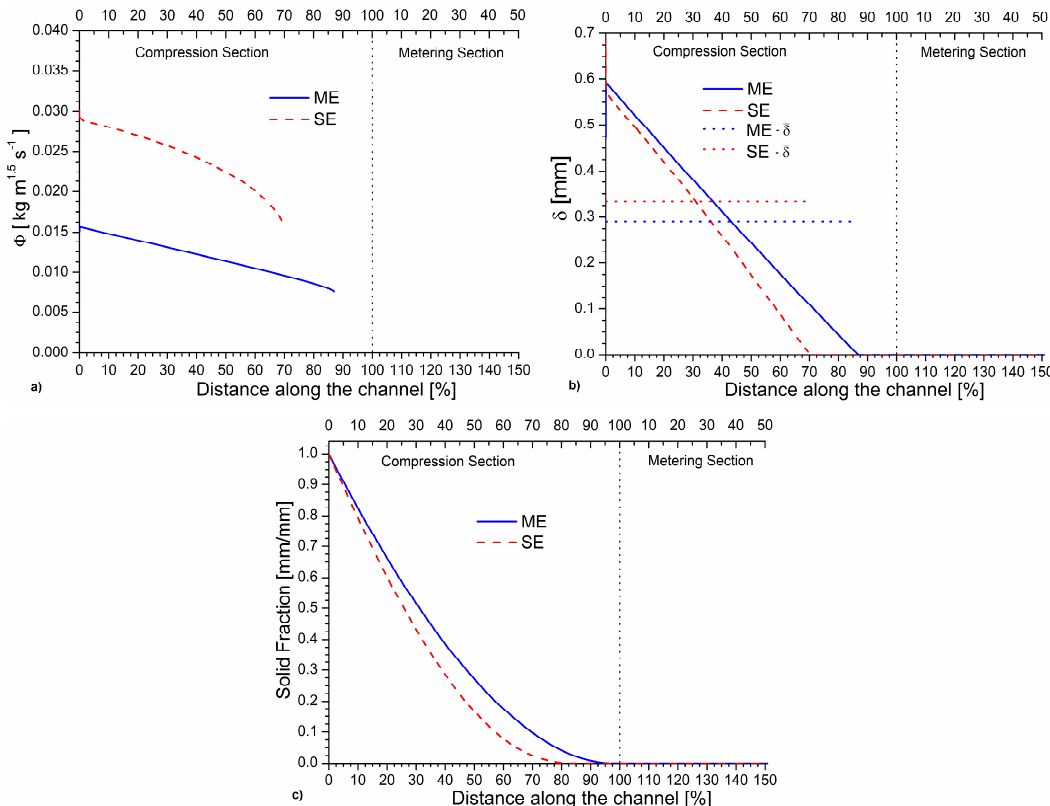
Figure 4. Extra information for Figure 3 regarding: ( a ) melting efficiency parameter Φ ; ( b ) melt film layer thickness δ ; and ( c ) solid bed profile. In ( b ), the overall average melt layer thickness ( 𝛿̅ ) is also provided as horizontal lines.